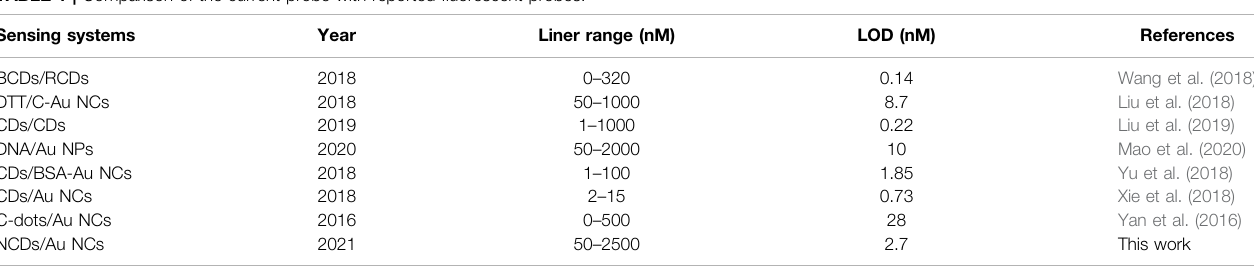
Frontiers in Chemistry |